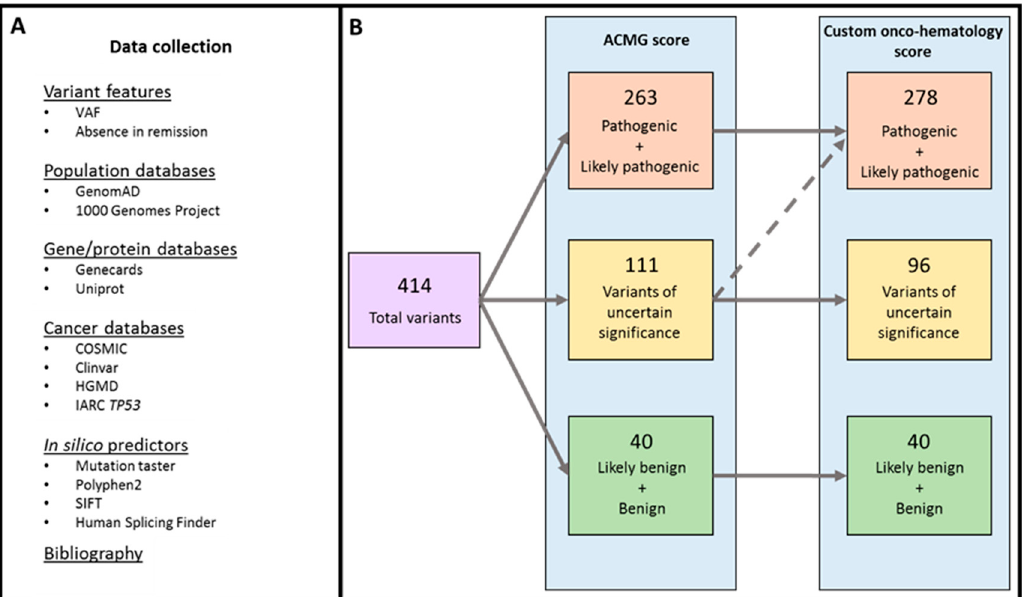
Figure 1. Algorithm for classification of variant pathogenicity. ( A ): Multiple databases were consulted. ( B ): The information was introduced in the American College of Medical Genetics and